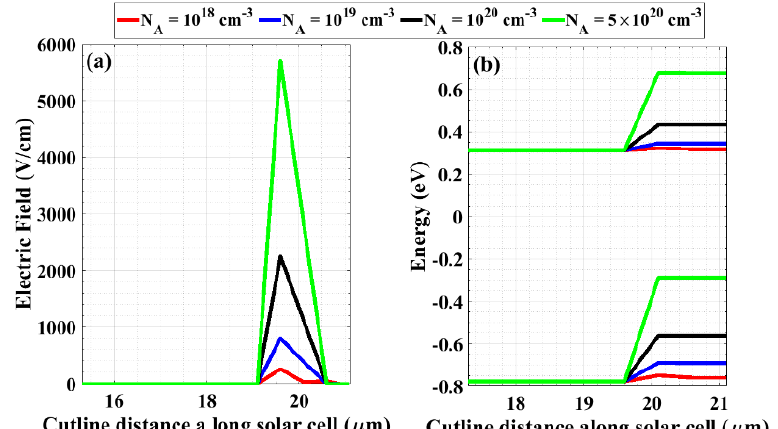
Figure 9. ( a ) Electric field distribution at different BSF doping concentrations near the rear interfaces, and ( b ) an illustration of the energy band diagram near the back interfaces for different values of BSF doping density.